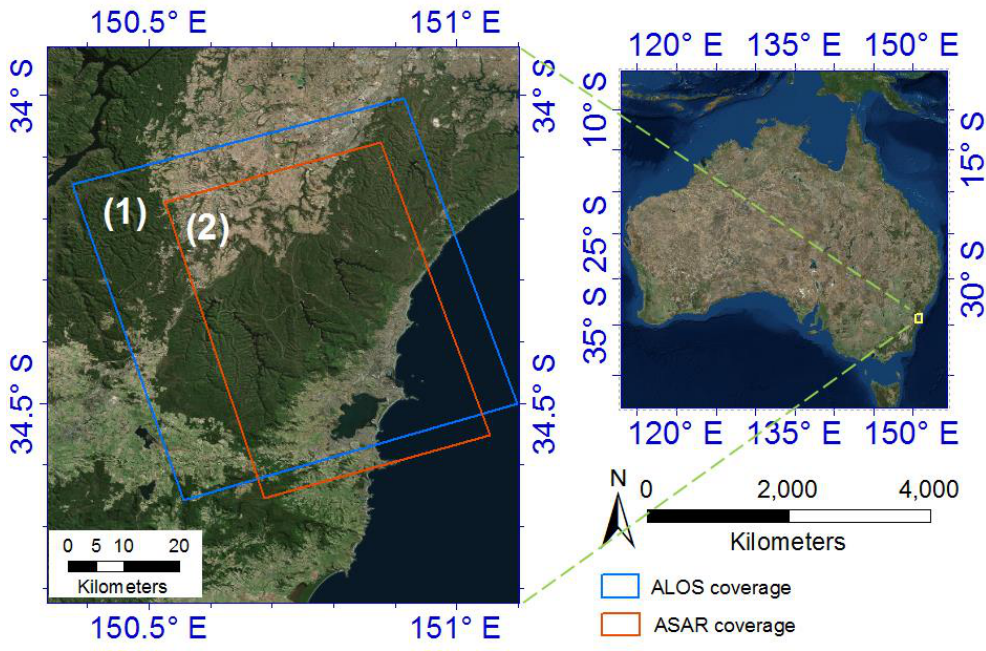
Figure 1. The coverage of ALOS-1 PALSAR image stacks (1) and ENVISAT ASAR image pairs (2).